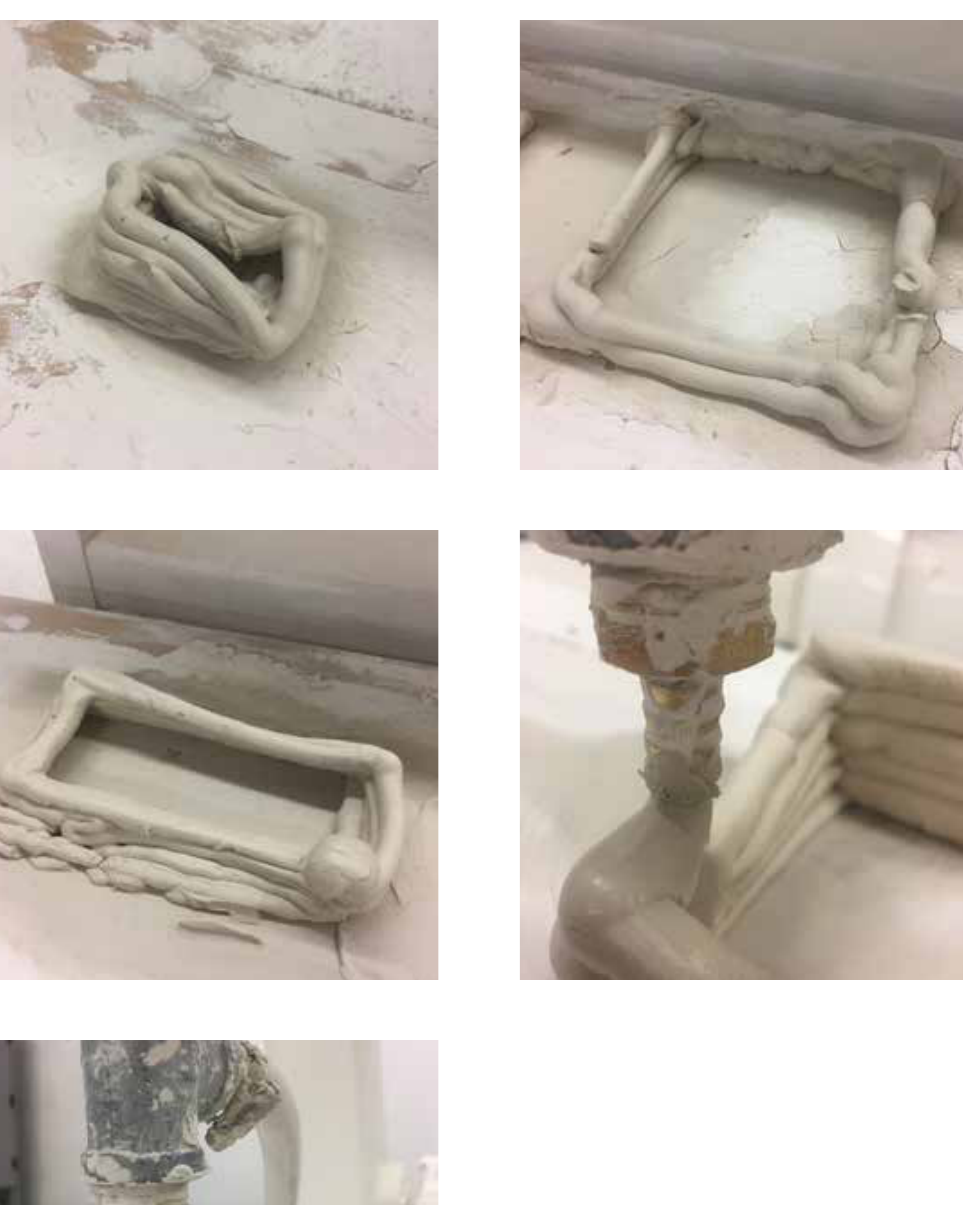
Figure 10 (opposite page): First extrusion of the toolpath.